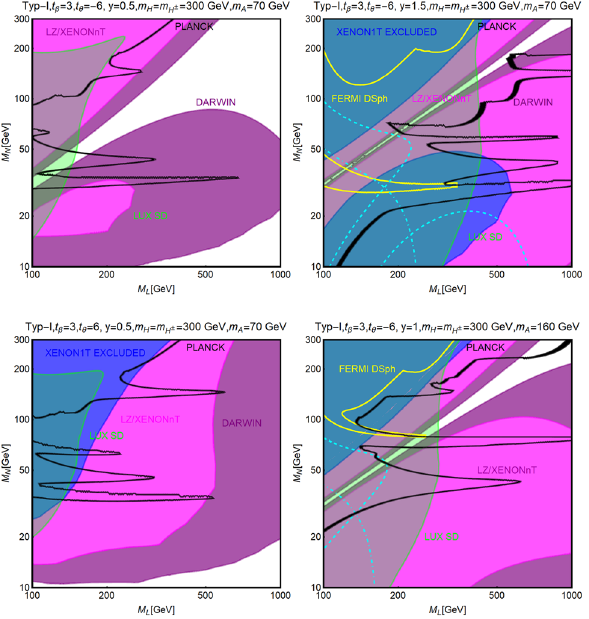
Fig. 6 Summary of DM constraints for some realizations of the Type-I model (Typ-I in the label of the panels) with low mass pseu- doscalar Higgs. As usual, the black contours correspond to the cor- rect relic density while the blue/magenta/purple regions correspond to the present/future exclusions by XENON1T/XENONnT/DARWIN. In addition we have reported in green the excluded regions from SD limits, as provided by LUX. In the right panels the regions within the dashed (dot-dashed) cyan lines are excluded by the constraints on the invisible width of the Higgs ( Z ) boson while the regions inside the yellow con- tours are excluded by constraints from searches of γ -rays in DSph by